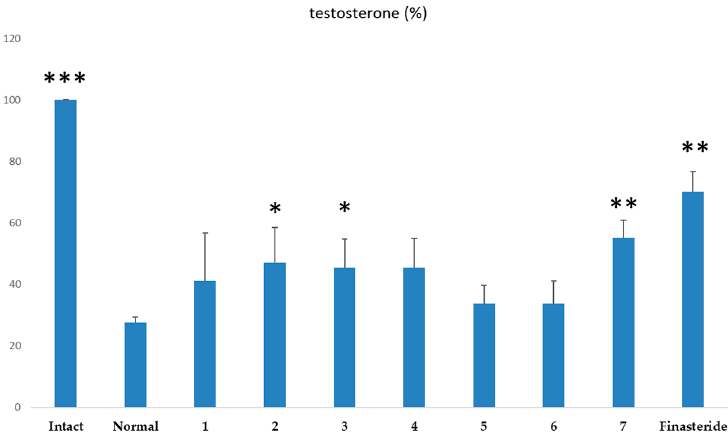
Figure 3. Inhibitory activities on 5 α -reductase with testosterone as substrate. Values were expressed as mean ± S.D of triplicate measurements ( n = 3) at four independent experiments. * p < 0.05, ** p < 0.01, *** p < 0.001 versus control group.